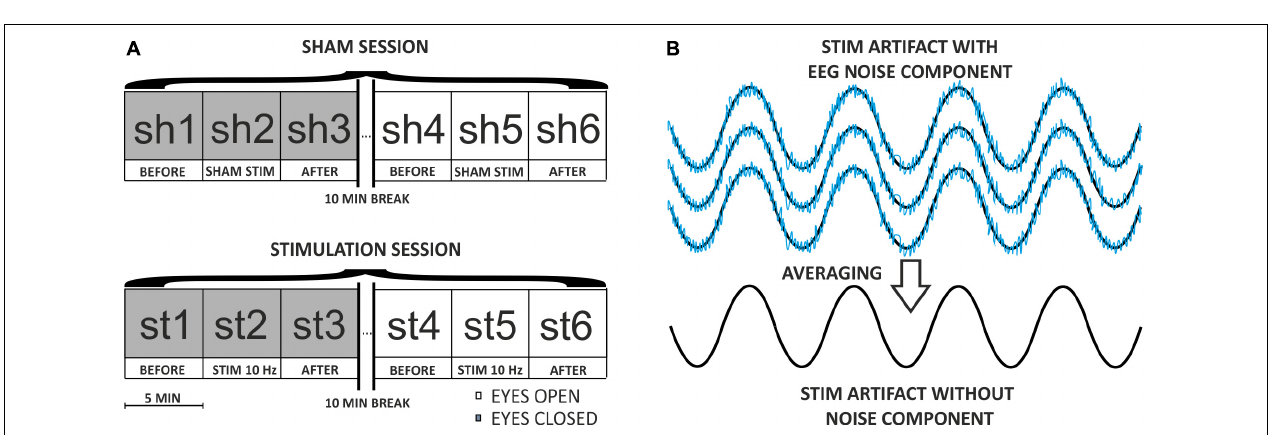
FIGURE 3 | (A) Diagram of the experimental procedure on the first participant. The procedure consisted of two continuous 15-min blocks (one with eyes closed, one with eyes open) repeated over the course of two subsequent days (SHAM and STIMULATION). A 10-min break separated each block, and EEG data were not recorded during the breaks. During every 15-min session, the stimulation lasted 5 min, and had a frequency of 10 Hz and an amplitude of 20 µ A. (B) Diagram of the coherent averaging idea. In this example, four noisy sinusoidal segments compatible with phase are averaged resulting in a “pure” sinusoidal signal. The noise component with a low amplitude represents endogenous EEG activity embedded in a high-amplitude sinusoidal wave representing an ACS artifact. The noise after averaging is close to 0, which indicates that coherent averaging sets information about endogenous EEG activity to zero and thus allows for the acquisition of the ACS artifact template (i.e., sinusoidal